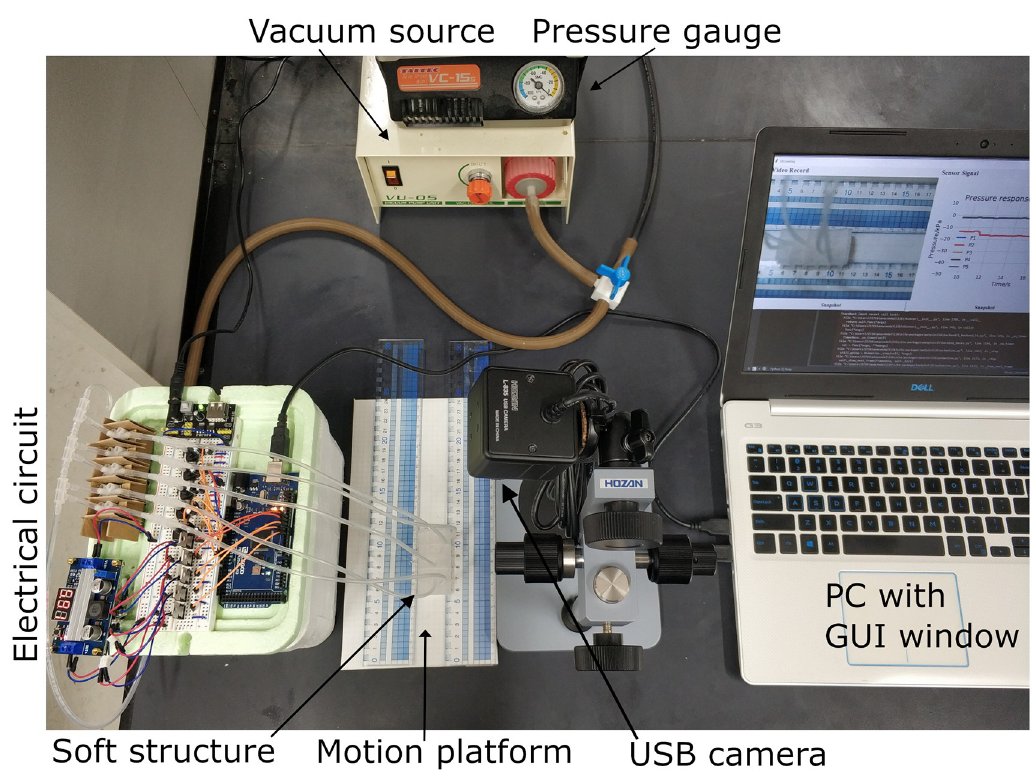
Fig 4. System overview. The soft robot system includes the following: the soft structure, electrical circuits, the vacuum source and pressure gauge, a motion platform, a USB camera and a PC with a GUI window.